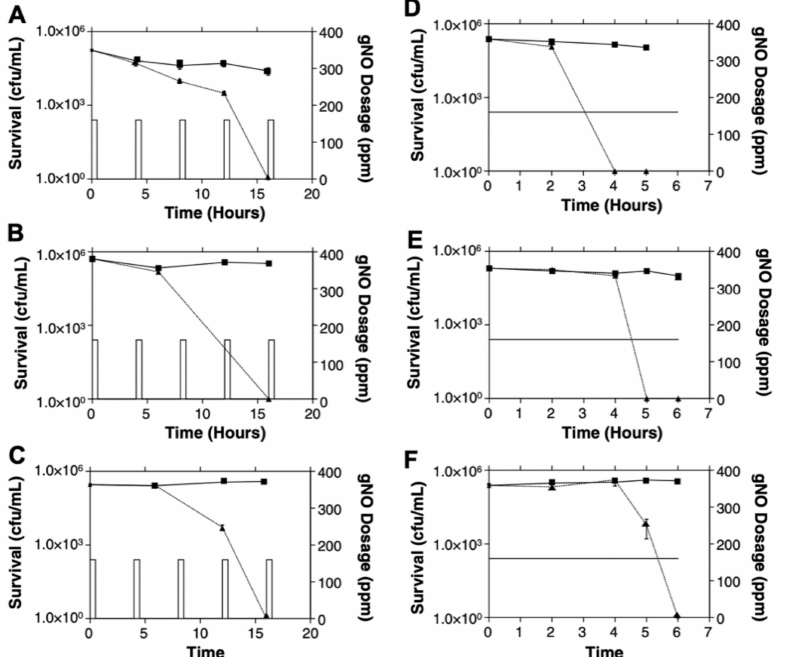
Figure 2. Bacterial survival curves during treatment with intermittent high-dose NO ( A – C ) or continuous high-dose NO ( D – F ). Bacteria were exposed to intermittent high-dose NO (160 ppm) for 30 min every 3.5 h for a total of 15 h (( A – C ) triangles) or continuous 160 ppm NO (( D – F ) triangles) for 6 h and compared to controls treated with medical air (squares). ( A , D ) Staphylococcus aureus ; ( B , E ) Pseudomonas aeruginosa (cystic fibrosis clinical strain); ( C , F ) Escherichia coli . Reproduced with permission